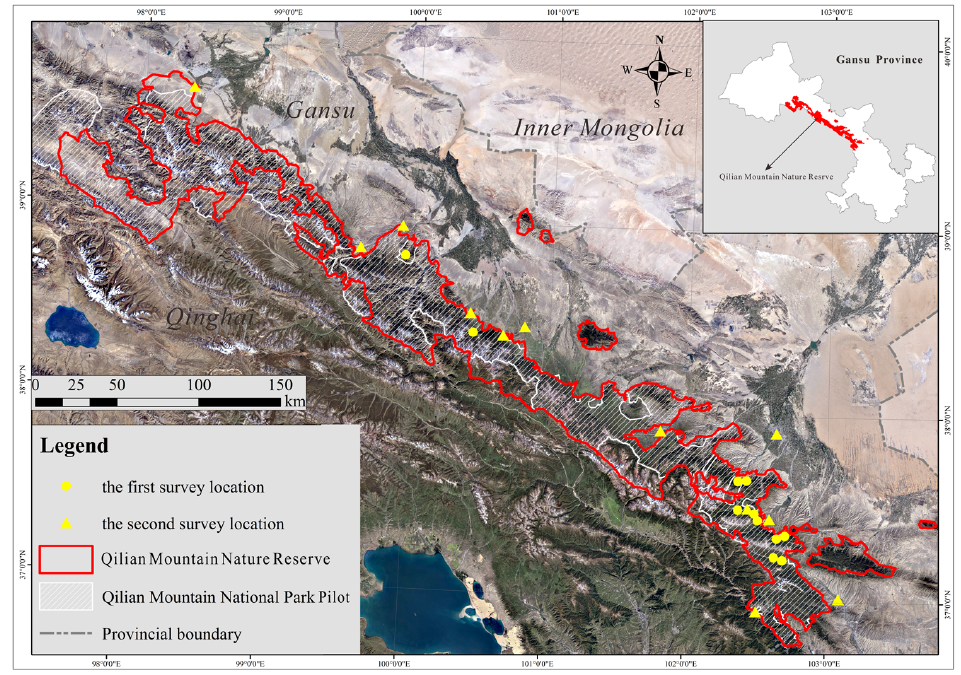
Figure 1. Study area.